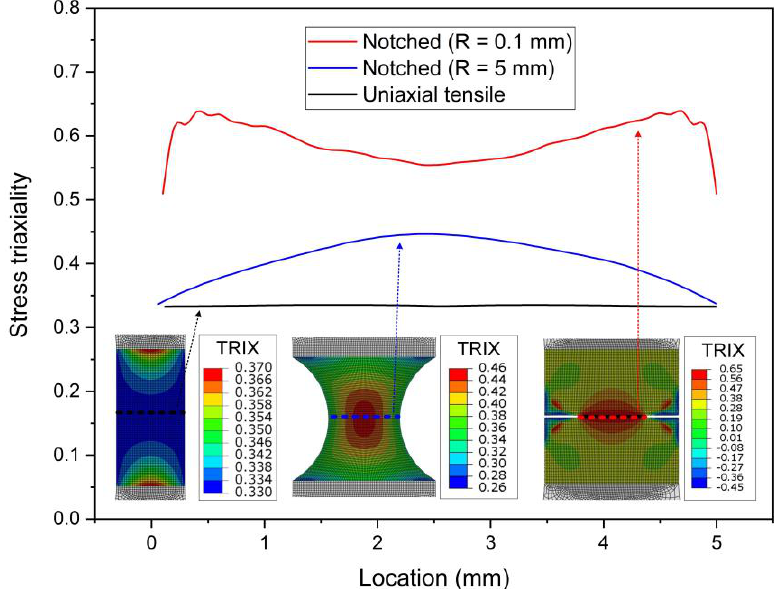
Figure 3. The initial stress triaxiality for the uniaxial tensile and the notched specimens. TRIX represents stress triaxiality.